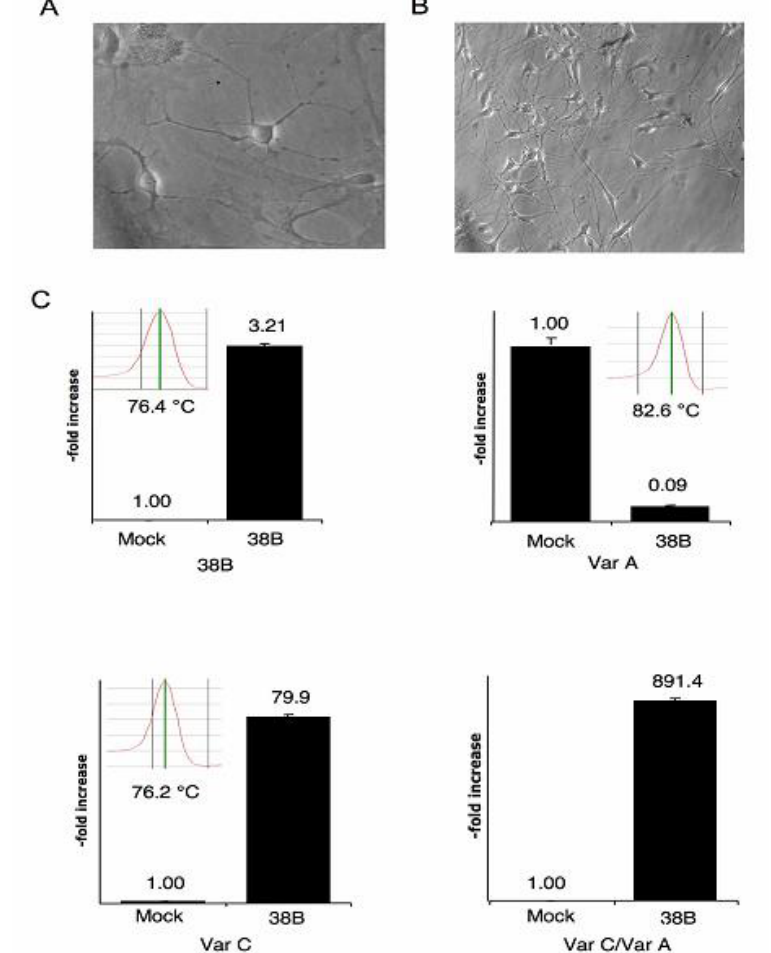
Figure 4. Hippocampal neurons after 6 ( A ) and 12 ( B ) days of in vitro culture; ( C ) The overexpression of 38B promotes the synthesis of an alternative KCNIP4 protein form as detected by Real Time RT-PCR analysis. Mock, pMock-transfected cells, 38B, p38B-transfected cells. The dissociation curves of the single amplification products are reported in the insets to demonstrate the single molecular species amplified.